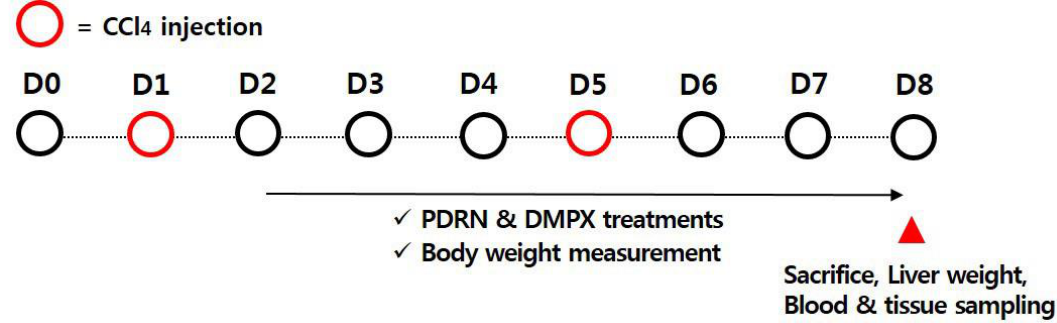
Figure 7. Experimental schedule.